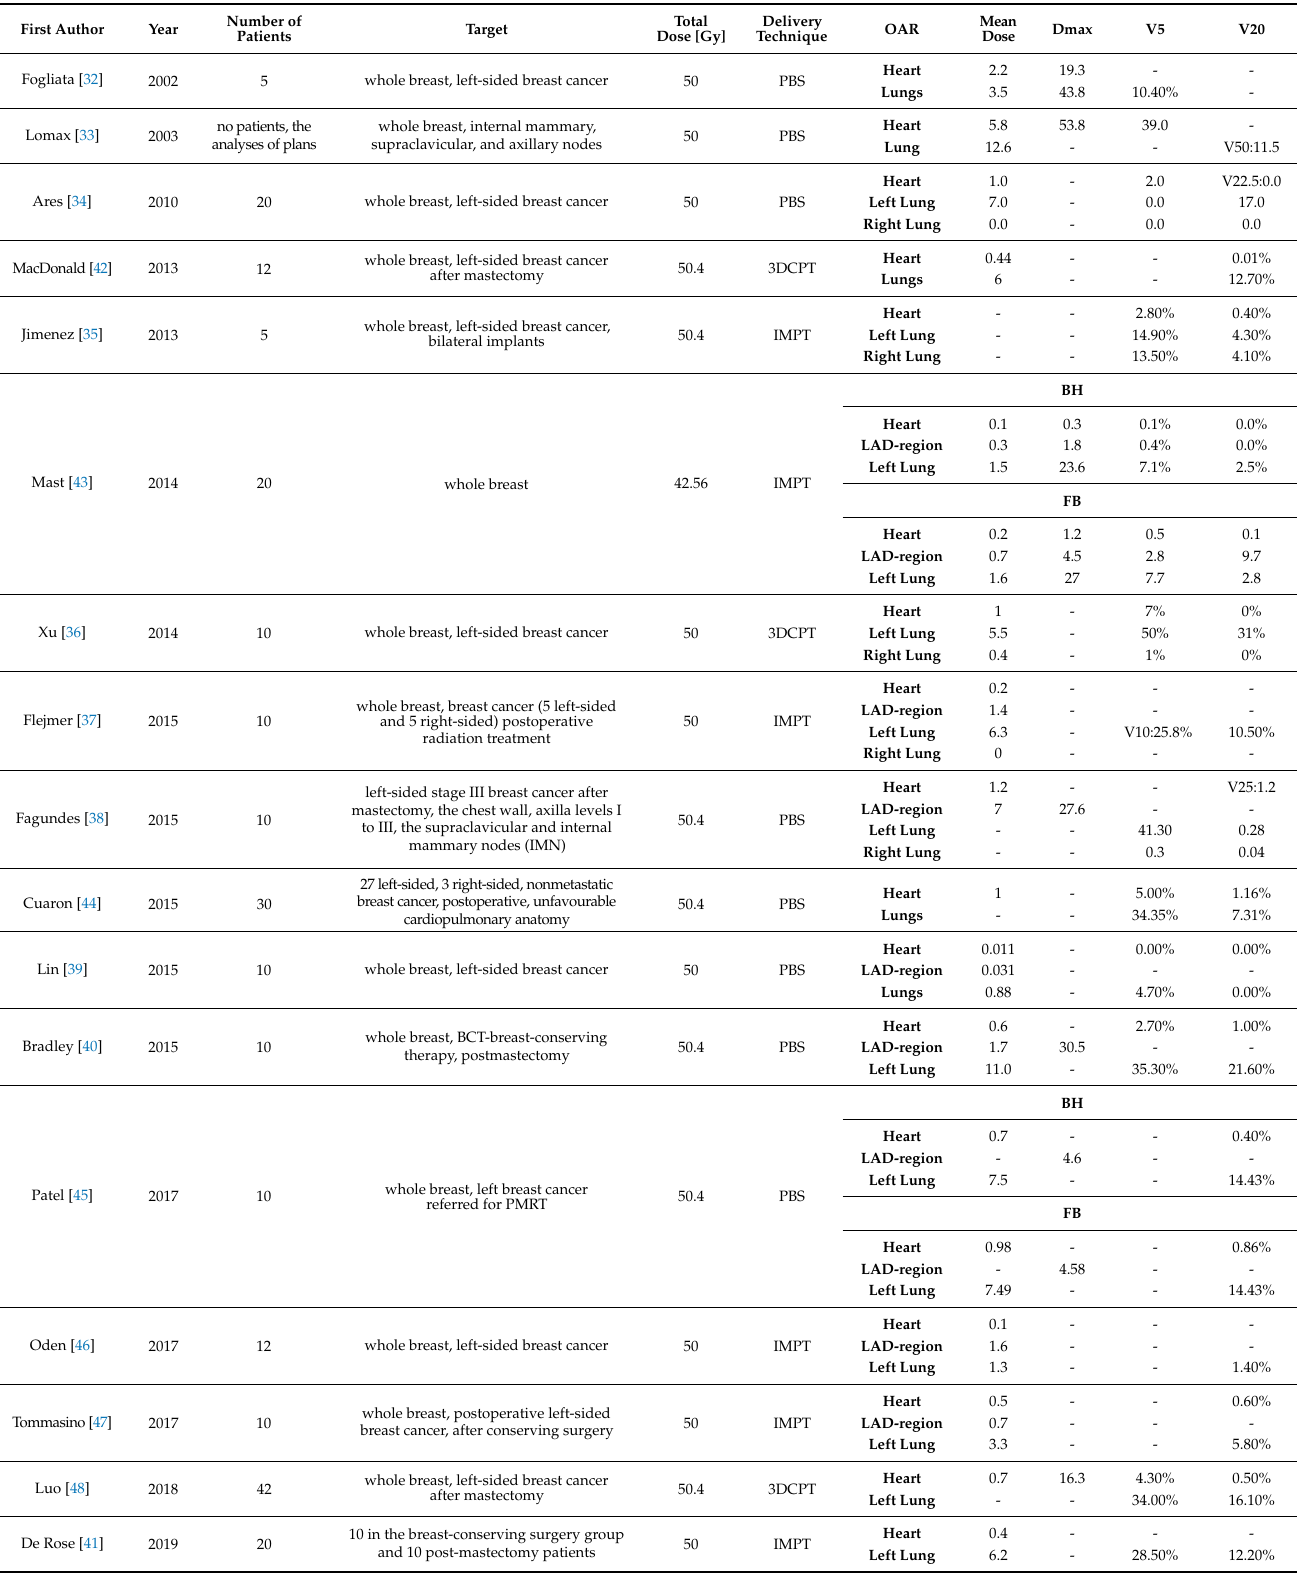
OAR—organ at risk; Dmax: maximum dose; V5—the volume of organ receiving 5 Gy; V20—the volume of organ receiving 20 Gy; APBI—accelerated partial breast irradiation; 3DCPT—three-dimensional conformal proton therapy; IMPT—intensity modulated proton therapy; PBS—pencil beam scanning; LAD—the left anterior descending artery; BH—breath holding, FB—free